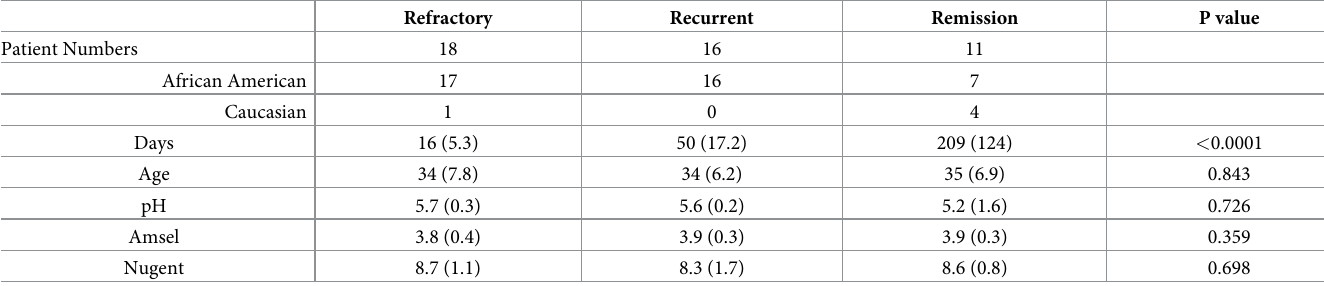
Table 2. Characteristics of BV patients and outcome groups at